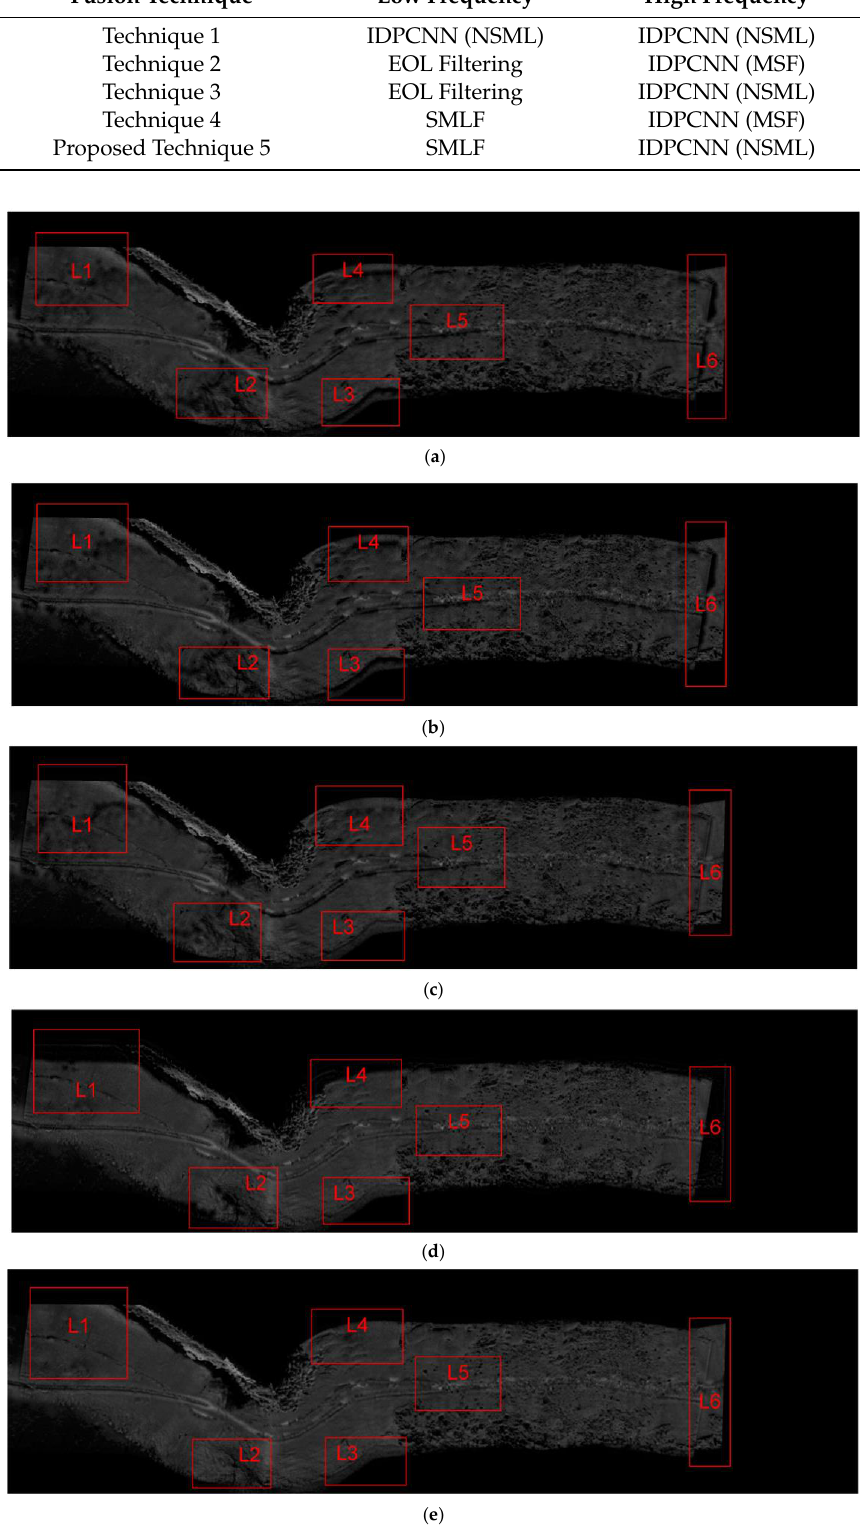
Figure 10. Fused image information of overlapping areas between adjacent strips. ( a ) Criterion 1. ( b